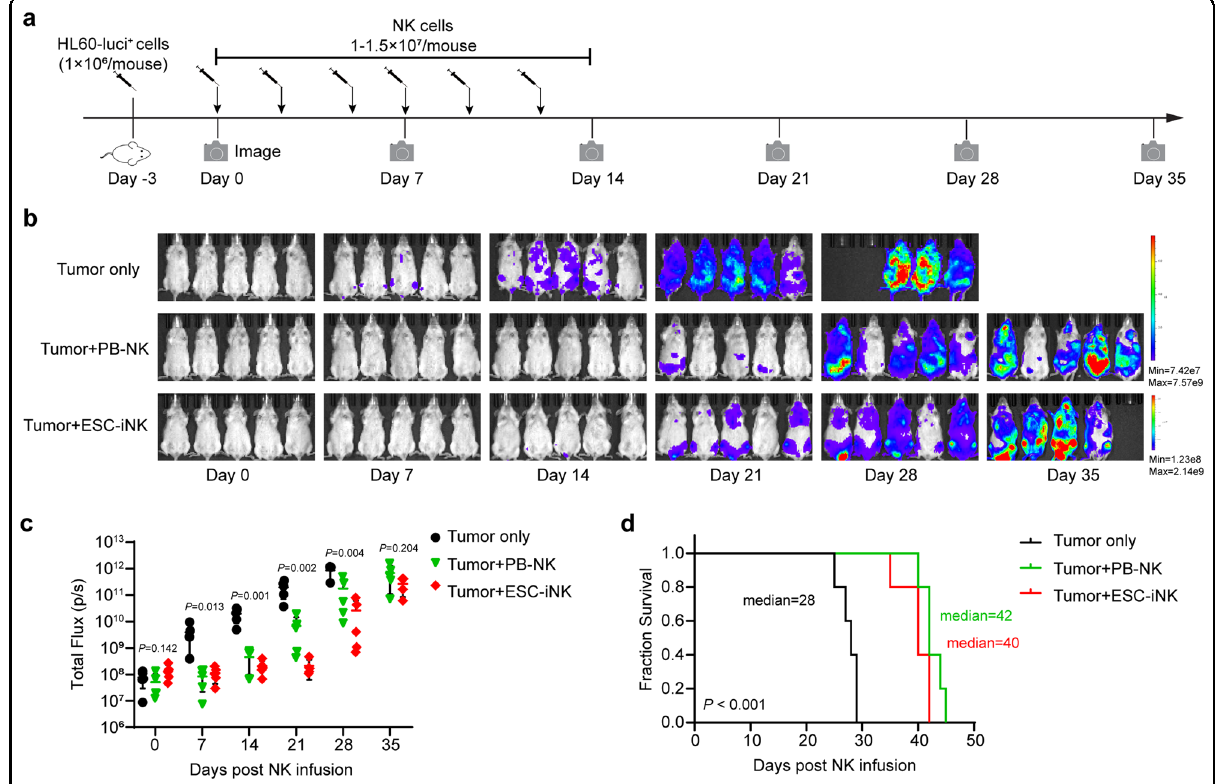
Fig. 6 ESC-derived iNK cells inhibit the development of AML in vivo. a Diagram of HL-60 cell xenogeneic B-NDG model for ESC-iNK cells against AML target in vivo. Mice were treated intravenously with PB-NK cells or ESC-iNK cells three times a week for 2 weeks. BLI was performed on Day 0, Day 7, Day 14, Day 21, Day 28, and Day 35. b Images of individual mouse radiance of the xenograft models (Tumor only, Tumor + PB-NK, and Tumor + ESC-iNK, n = 5 each group). The radiance indicates tumor burden. c Statistics of the total fl ux (p/s) of the xenograft models (mean± SD, n = 5). One-way ANOVA and two-tailed independent t -test. d Kaplan-Meier survival curves of the xenograft models ( P < 0.001, Log-rank test). Median survival times were